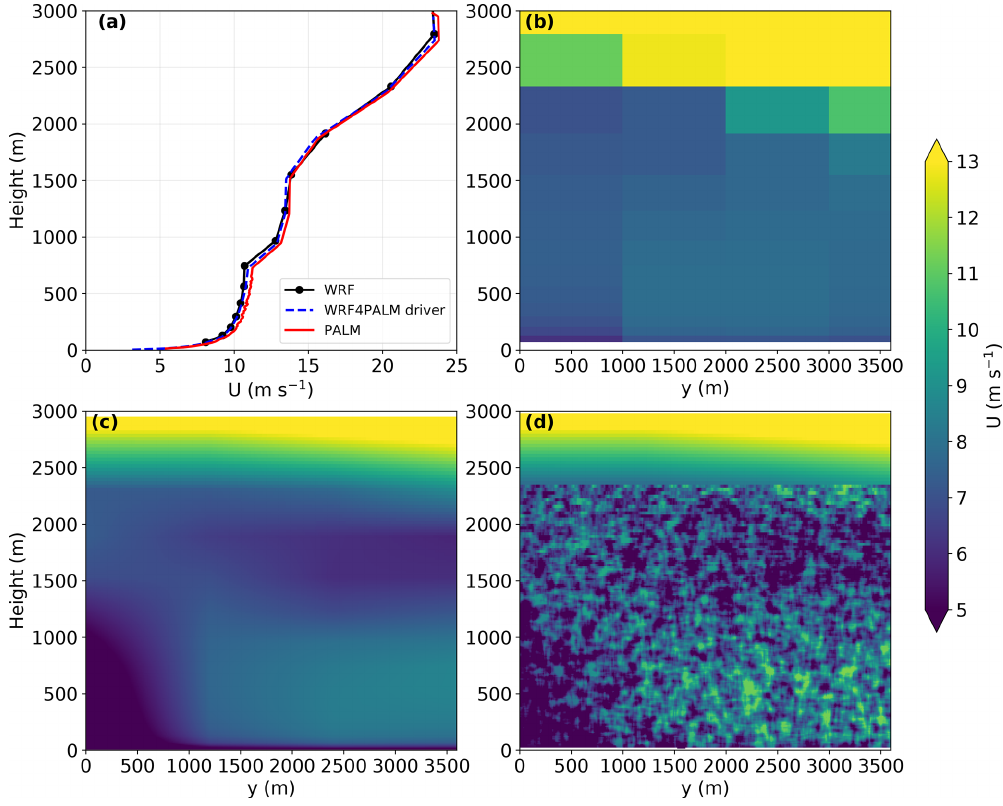
Figure 5. (a) Vertical profiles of the u component of winds in WRF, the WRF4PALM dynamic driver, and PALM at the initial time. The profiles taken from WRF and PALM are both horizontally averaged. Vertical cross sections of the u component of winds taken from WRF (nearest four grid cells) (b) , the dynamic driver (c) , and PALM (d) at 14:00NZDT, 14 February